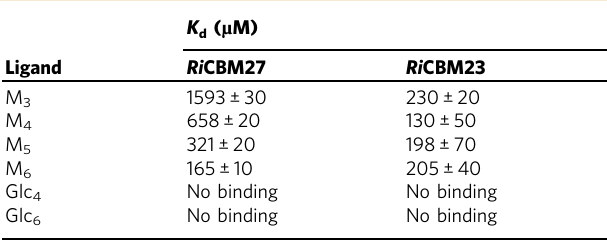
Table 1 Binding parameters of Ri CBM27 and Ri CBM23 to